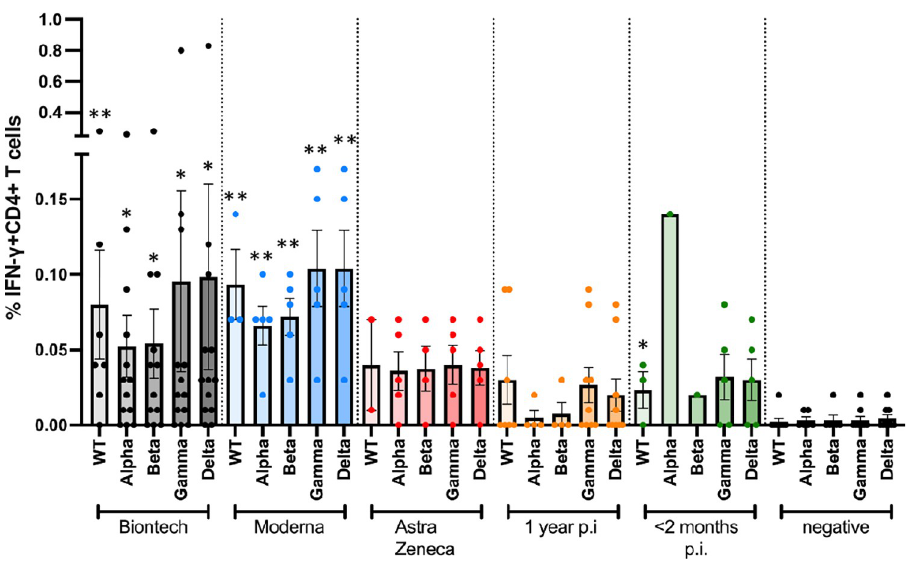
Fig 4. Antigen-specific IFN- γ CD4+ T cell responses to JPT peptide S protein wt and mutant pools. Antigen- specific CD4+ T cell responses elicited by the JPT peptide S protein pools after vaccination with BioNtech (grey), Moderna (blue) or AstraZeneca (red), or one year (orange) or < 2 months (dark green) after naturally occurring infection with SARS-CoV2, or negative controls. The bar graphs show frequencies of IFN γ +CD4+ T cells for wild type, and for alpha (B.1.1.7), beta (B.1.351), gamma (P.1) and delta (B.1.617.2) mutants. The figure shows results of n = 13 independent individuals after vaccination with BioNtech, n = 5 Moderna, n = 5 AstraZeneca, and n = 10 independent individuals one year and n = 7 subjects < 2 months after natural infection, and n = 9 negative controls, with standard errors of the mean (SEM). Significance levels were tested with Kruskal-Wallis test for non-parametric samples. � p < 0.05 vs. healthy controls; �� p < 0.01 vs. healthy controls and p < 0.05 vs 1 year after infection.